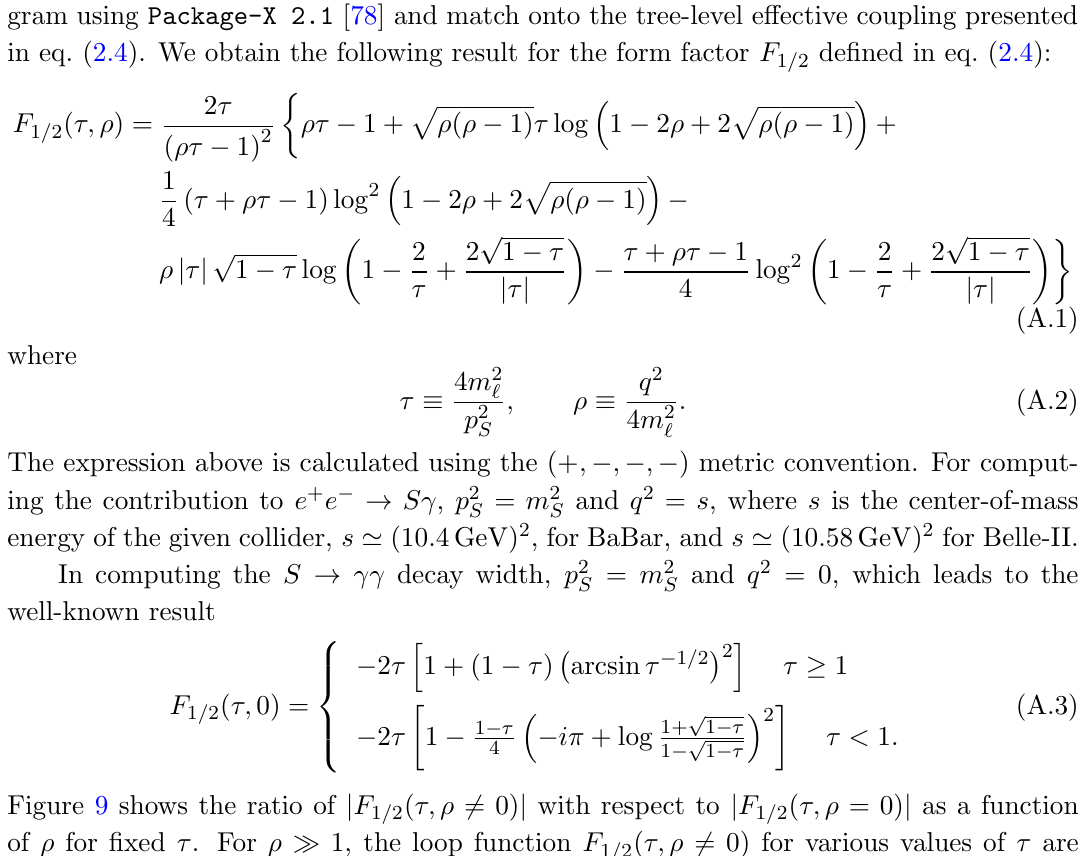
Figure 9. The ratio of the absolute values of the S(cid:13)(cid:13) loop function F and on-shell ( (cid:26) = 0) photon leg for a various values of (cid:28) . The scalar and the other photon are taken to be